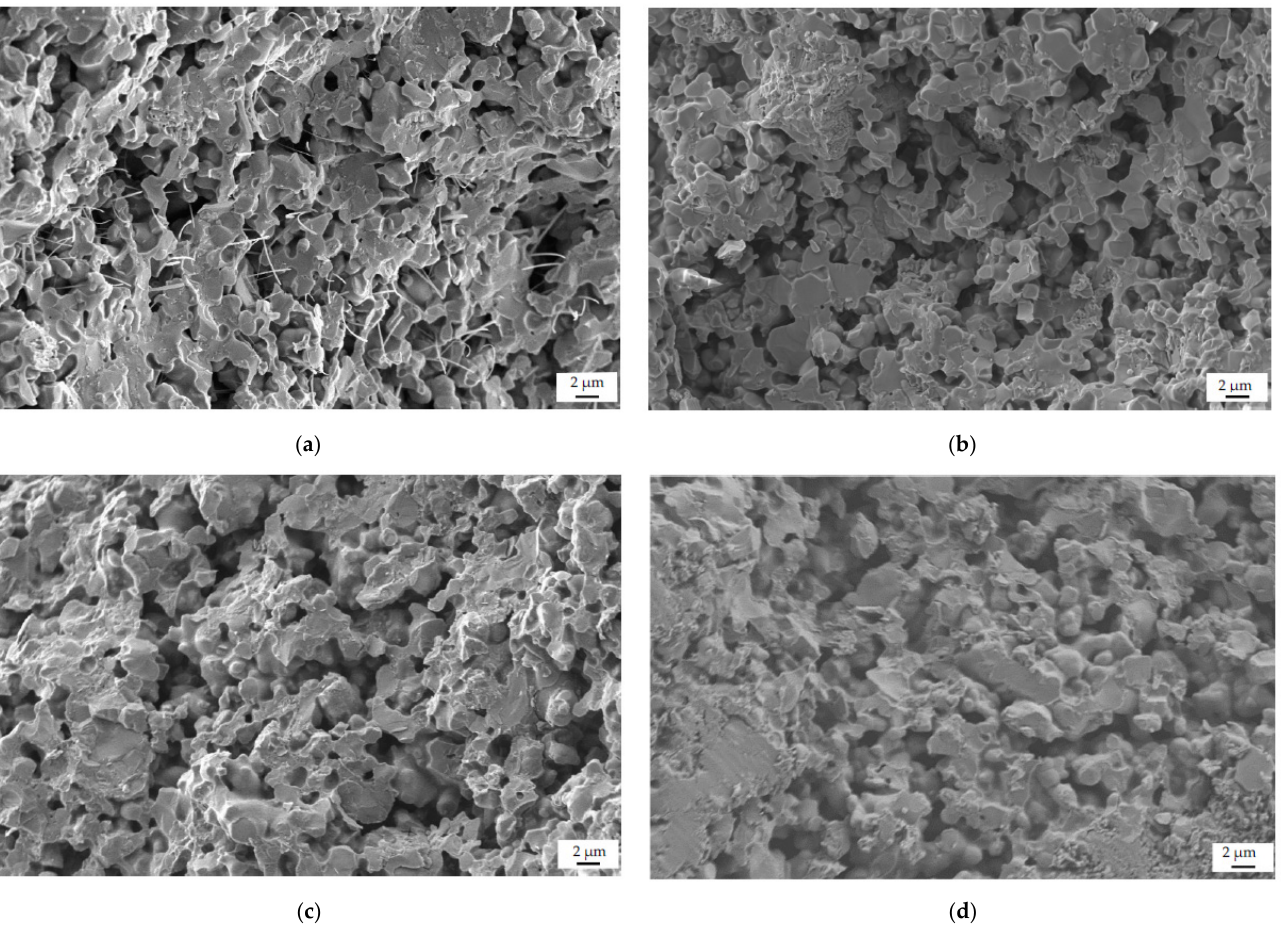
Figure 9. SEM micrographs of the ceramics after heat treatment at 500 °C ( a ), 700 °C ( b ), 900 °C ( c ) and 1100 °C ( d ).